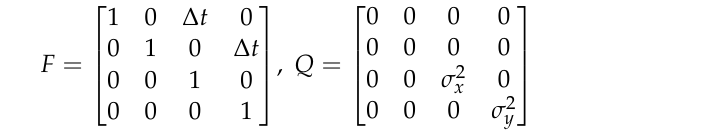
Figure 5. Kinematic bicycle model.